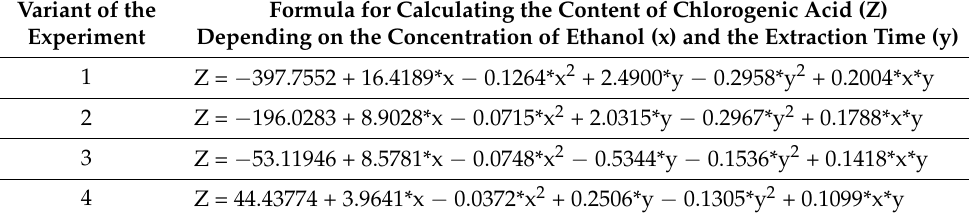
Table 2. Formulas for Calculating the Content of Chlorogenic Acid ( µ g/cm3) in ethanol extracts, depending on the research variant. Variant of the Formula for Calculating the Content of Chlorogenic Acid (Z) Experiment Depending on the Concentration of Ethanol (x) and the Extraction Time